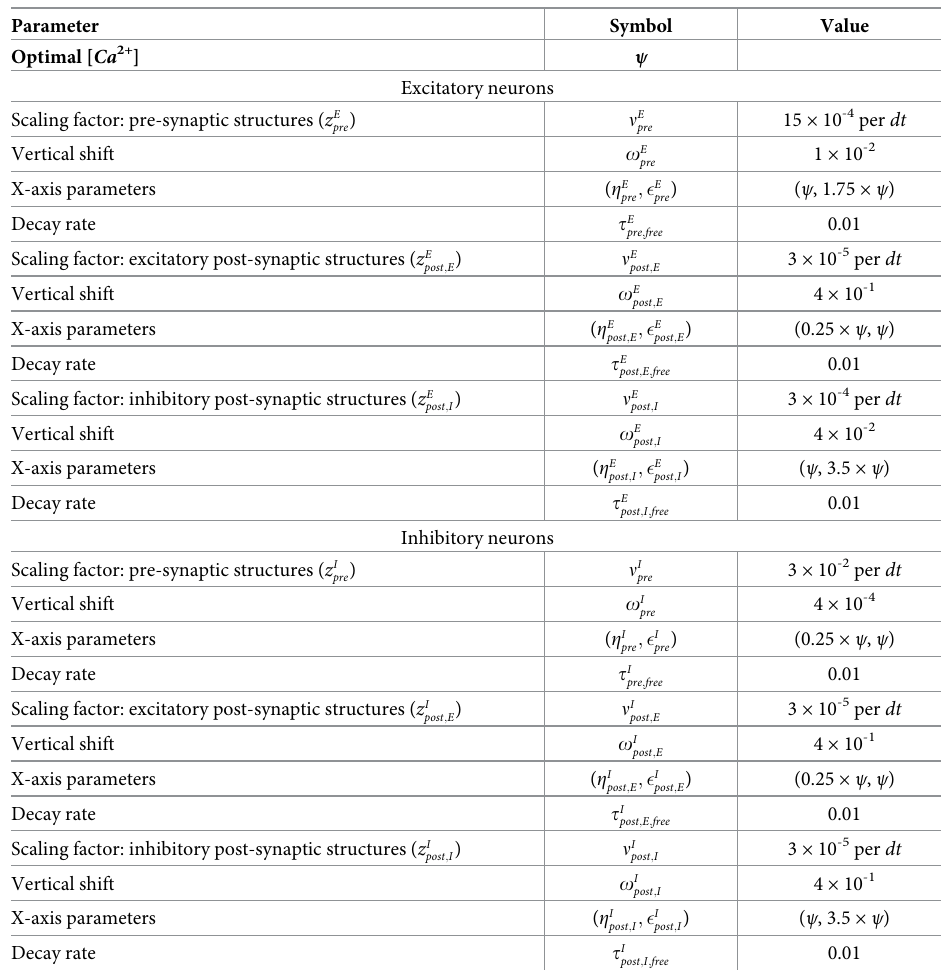
Table 4. Growth rule parameters.